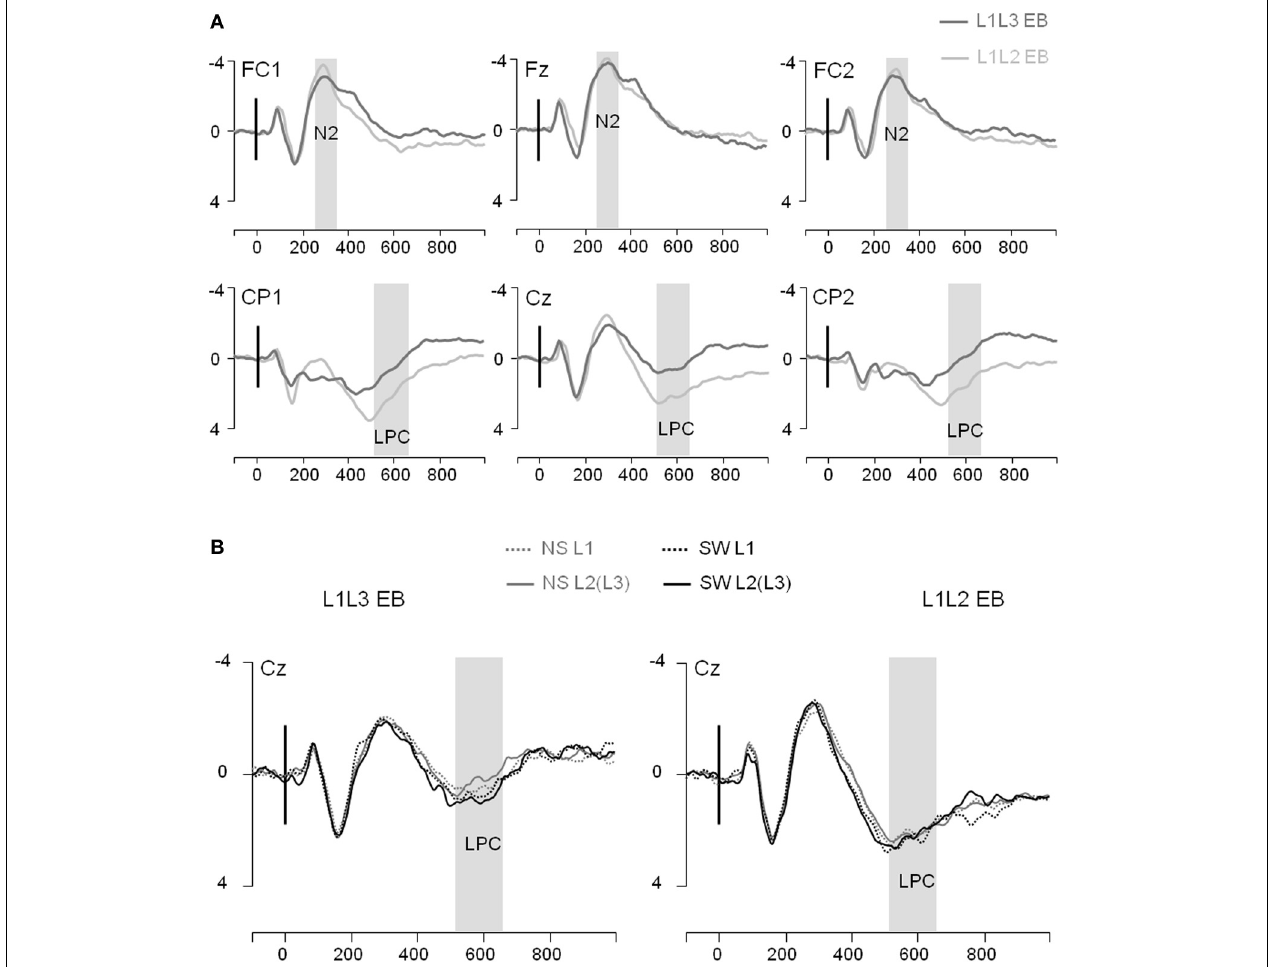
FIGURE 4 | Event-related potentials (Y axis: Mean amplitude in µ V) from the trial presentation (time 0) to 1000ms. (A) ERPs elicited by the presentation of a picture, for L1L3 EB group (dark gray waves) and L1L2 EB group (light gray waves) at 6 midline electrodes (FC1, Fz, FC2, CP1, Cz, CP2). (B) ERPs elicited by a no switch in L1 trial